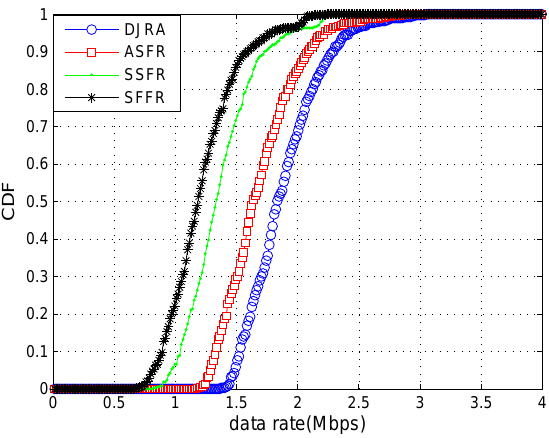
Figure 5. Data rate achieved by each user under different schemes.